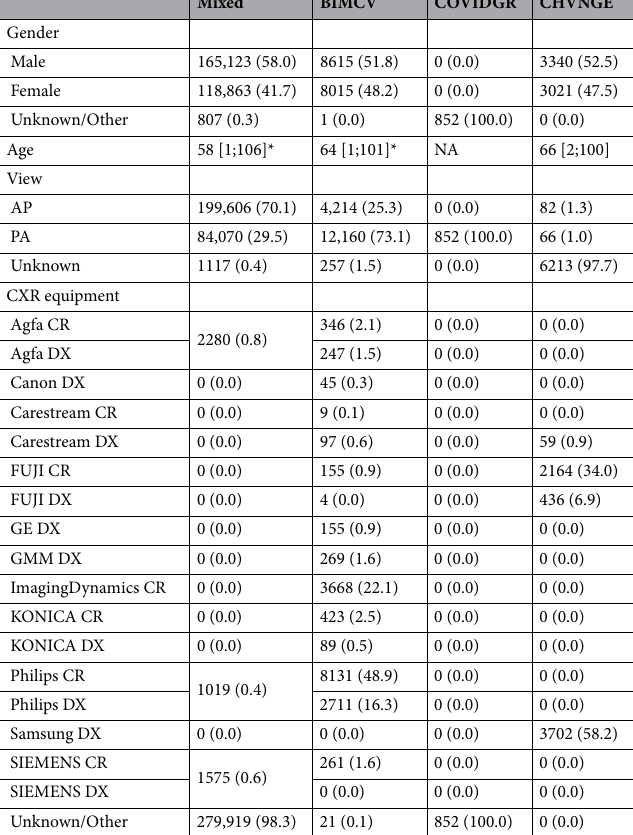
Table 2. Patient and CXR acquisition characteristics for each dataset. Data is shown in absolute number and percentage in parenthesis. Age is shown as median [minimum; maximum]. * indicates that the information could not be obtained for all subjects and NA indicates that this data is not